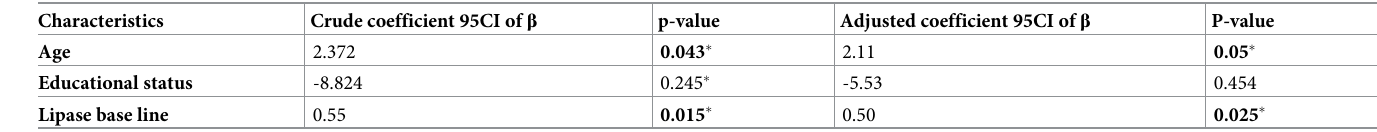
Table 7. Multiple linear regression between serum pancreatic lipase with different factor